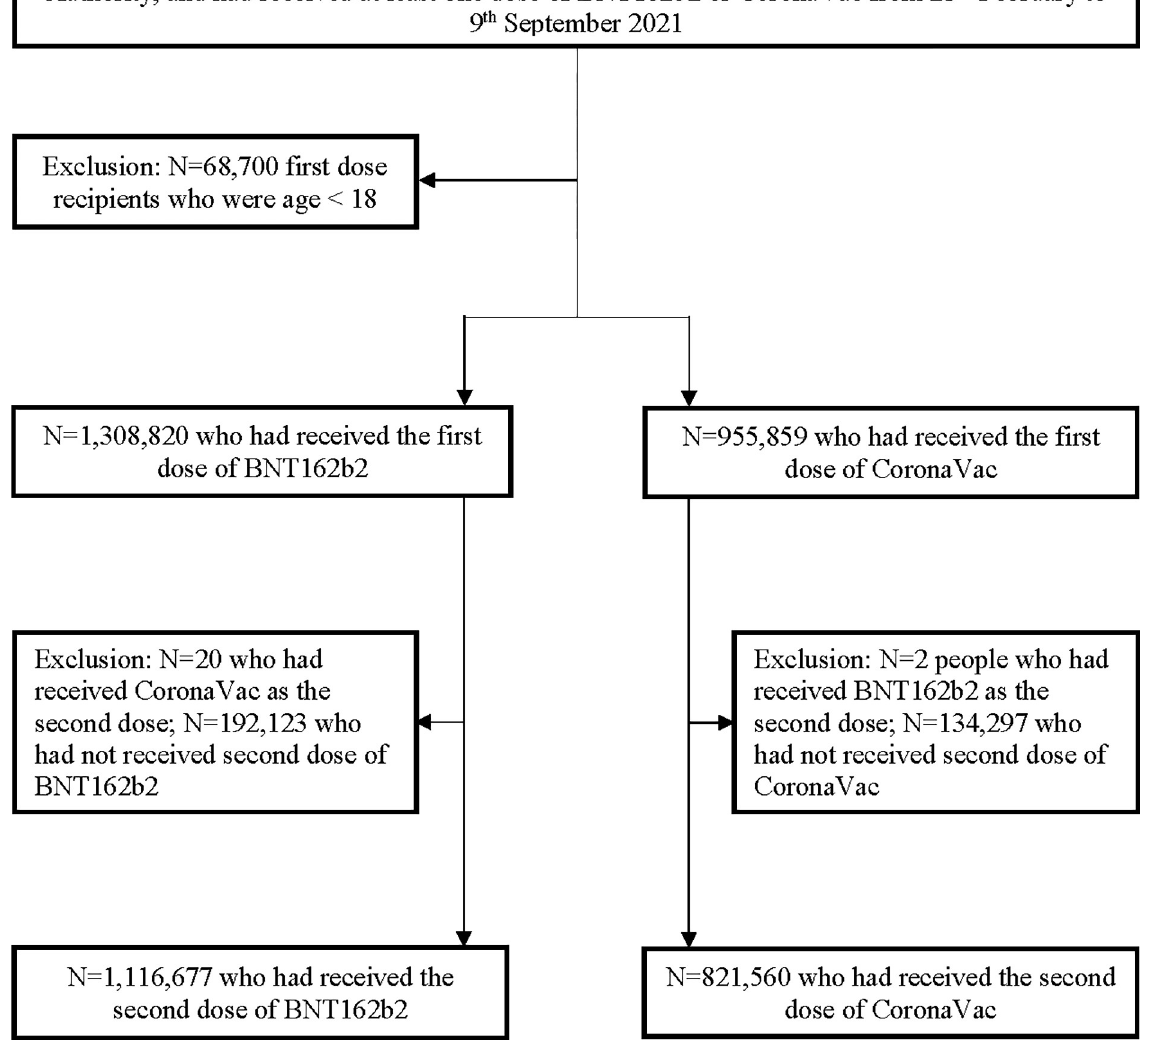
Fig 1. Inclusion and exclusion criteria for the analysis of individuals who received a first or second dose of BNT162b2 or CoronaVac from 23 February to 9 September 2021 in Hong Kong SAR, China.